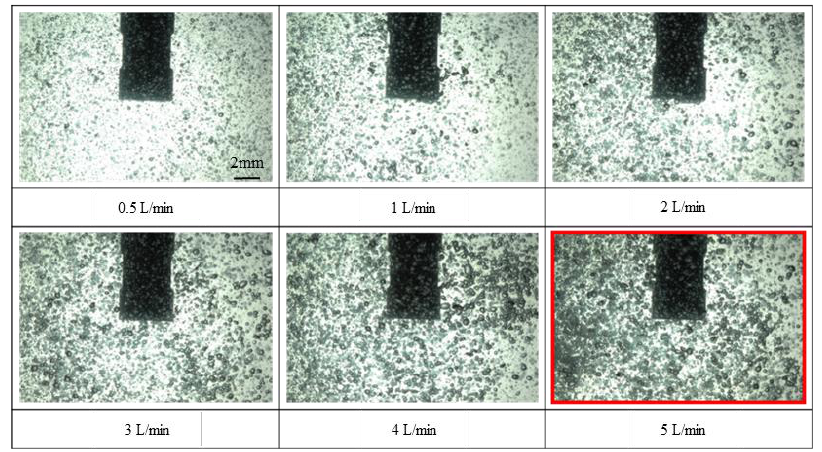
Figure 8. The distribution of microbubbles with different air-flow rates.